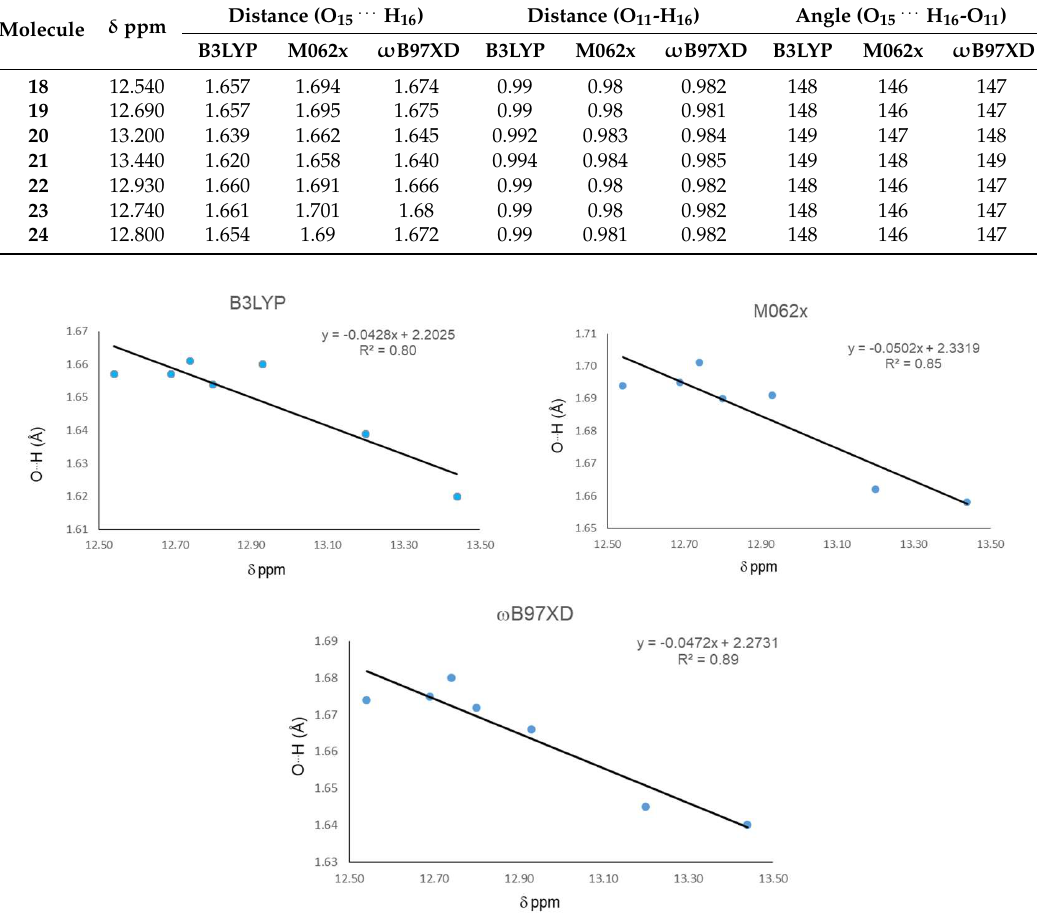
Figure 1. Correlations between H16 ... O15 distance and 1 H-NMR chemical shifts ( δ ) for the hydrogen bond.